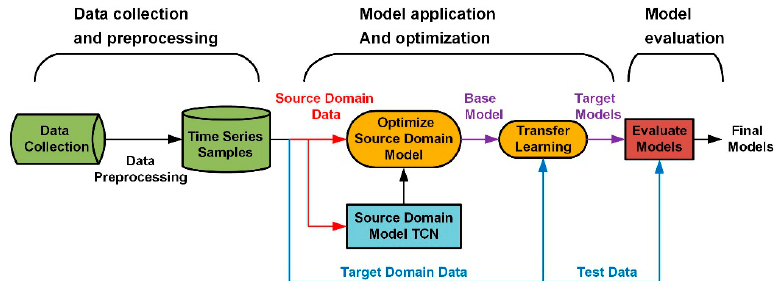
Figure 3. The first part preprocesses the collected original data, including the selection of relevant variables, the conversion of collected data into time series samples, the determination of sliding window size, as well as the determination of the source domain and target domain of this case. The second part trains and optimizes the structure and parameters of the TCN model according to the source domain data and then uses the target domain data to monitor and learn the basic model. In the third part, the prediction error and accuracy of the target domain model are evaluated by the target domain test and finally output the target model.